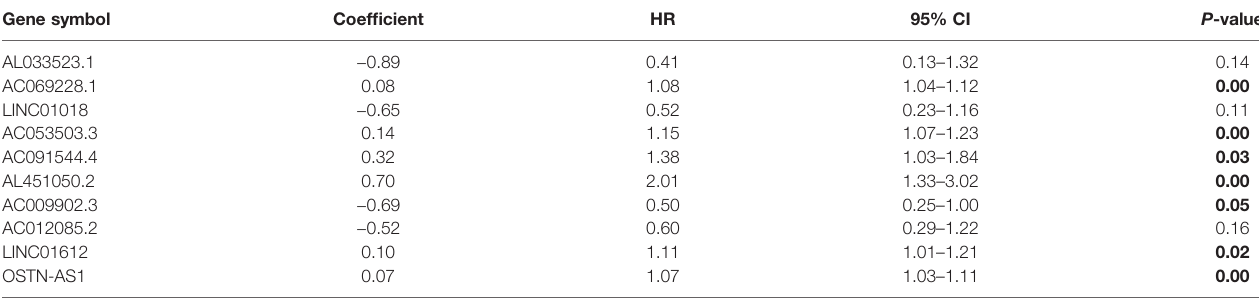
TABLE 1 | Multivariate Cox regression analyses of the 10 of 95 genome instability-related lncRNAs correlated with biochemical recurrence in PCa. Gene